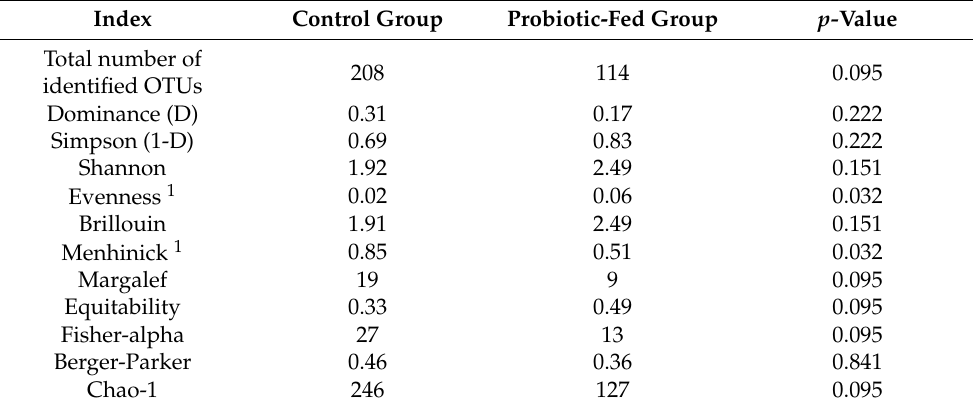
Table 3. Alpha-biodiversity indices (median) of fecal bacterial assemblages of ducks of the control and probiotic-fed group.